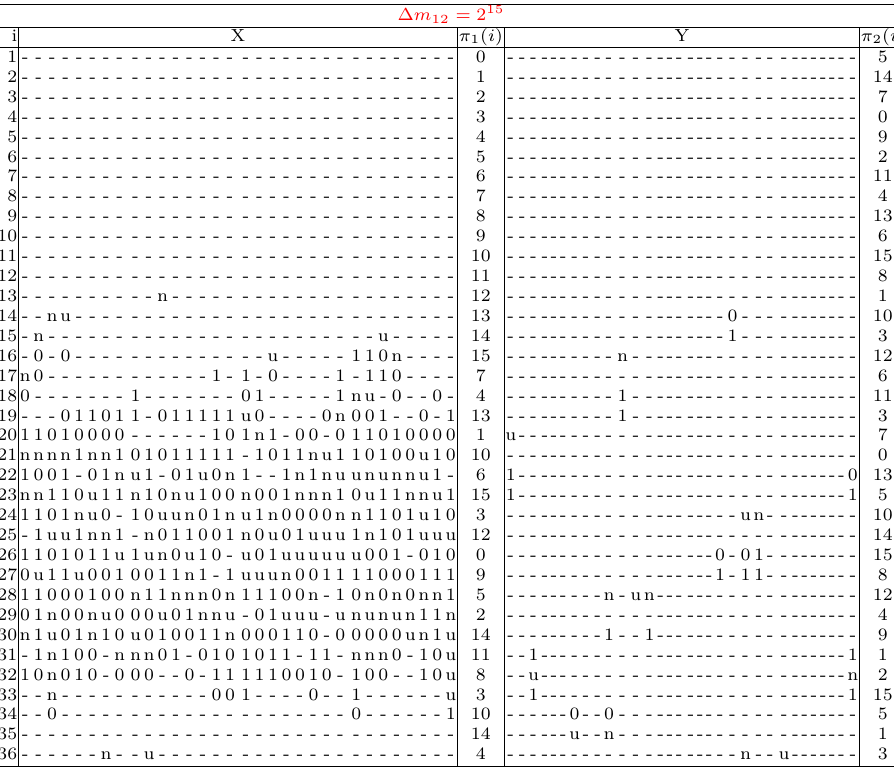
Table 12: 36-step differential